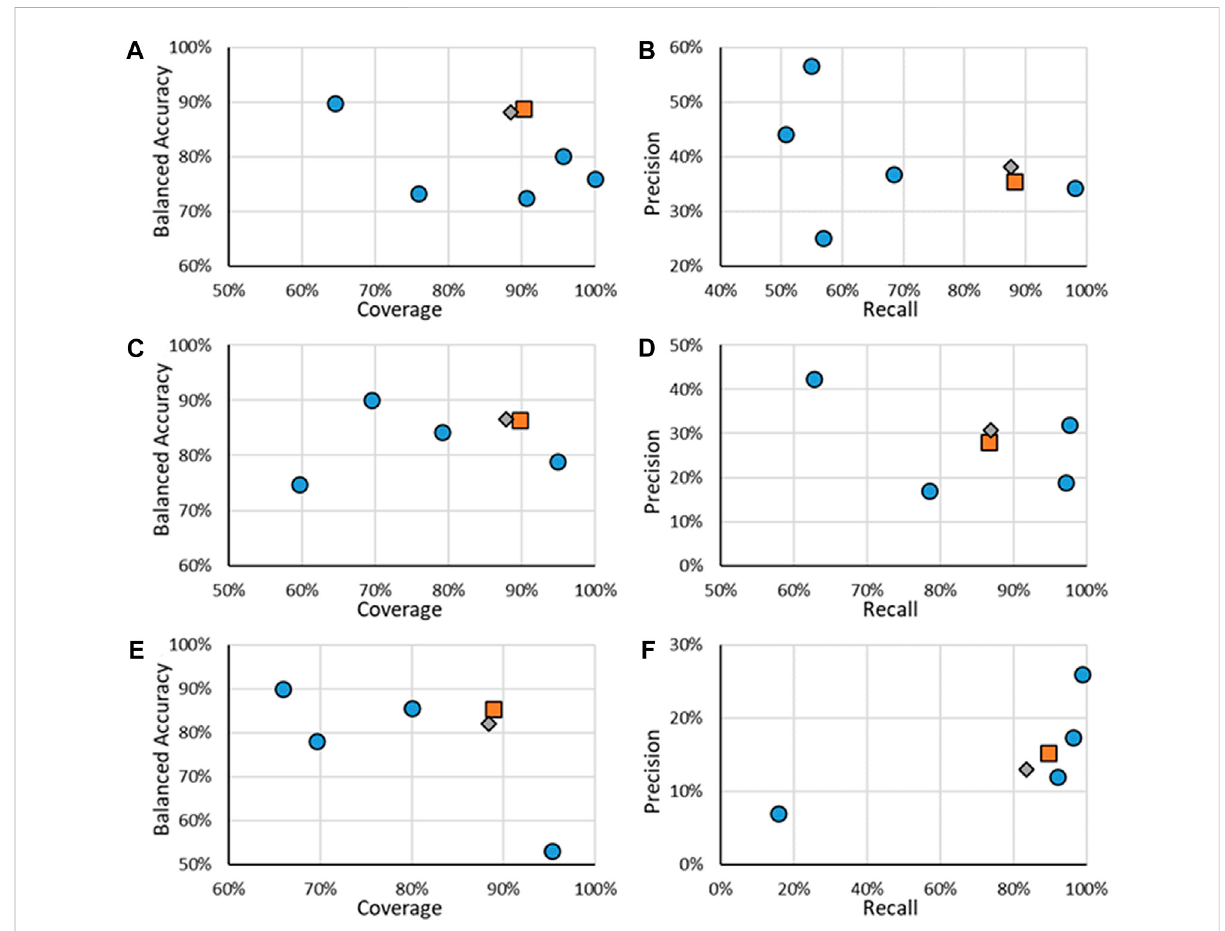
FIGURE 3 Statisticsof performance of the binary ER activity models for binding (A,B) , agonism (C,D) , and antagonism (E,F) . A, C, and E show the results of BA as a function of Coverage while B , D , and E show Precision as a function of Recall. Orange squares are for RF models when all substances are considered, gray diamonds are when only the substances in the RF test substances are considered, and blue circles are for other